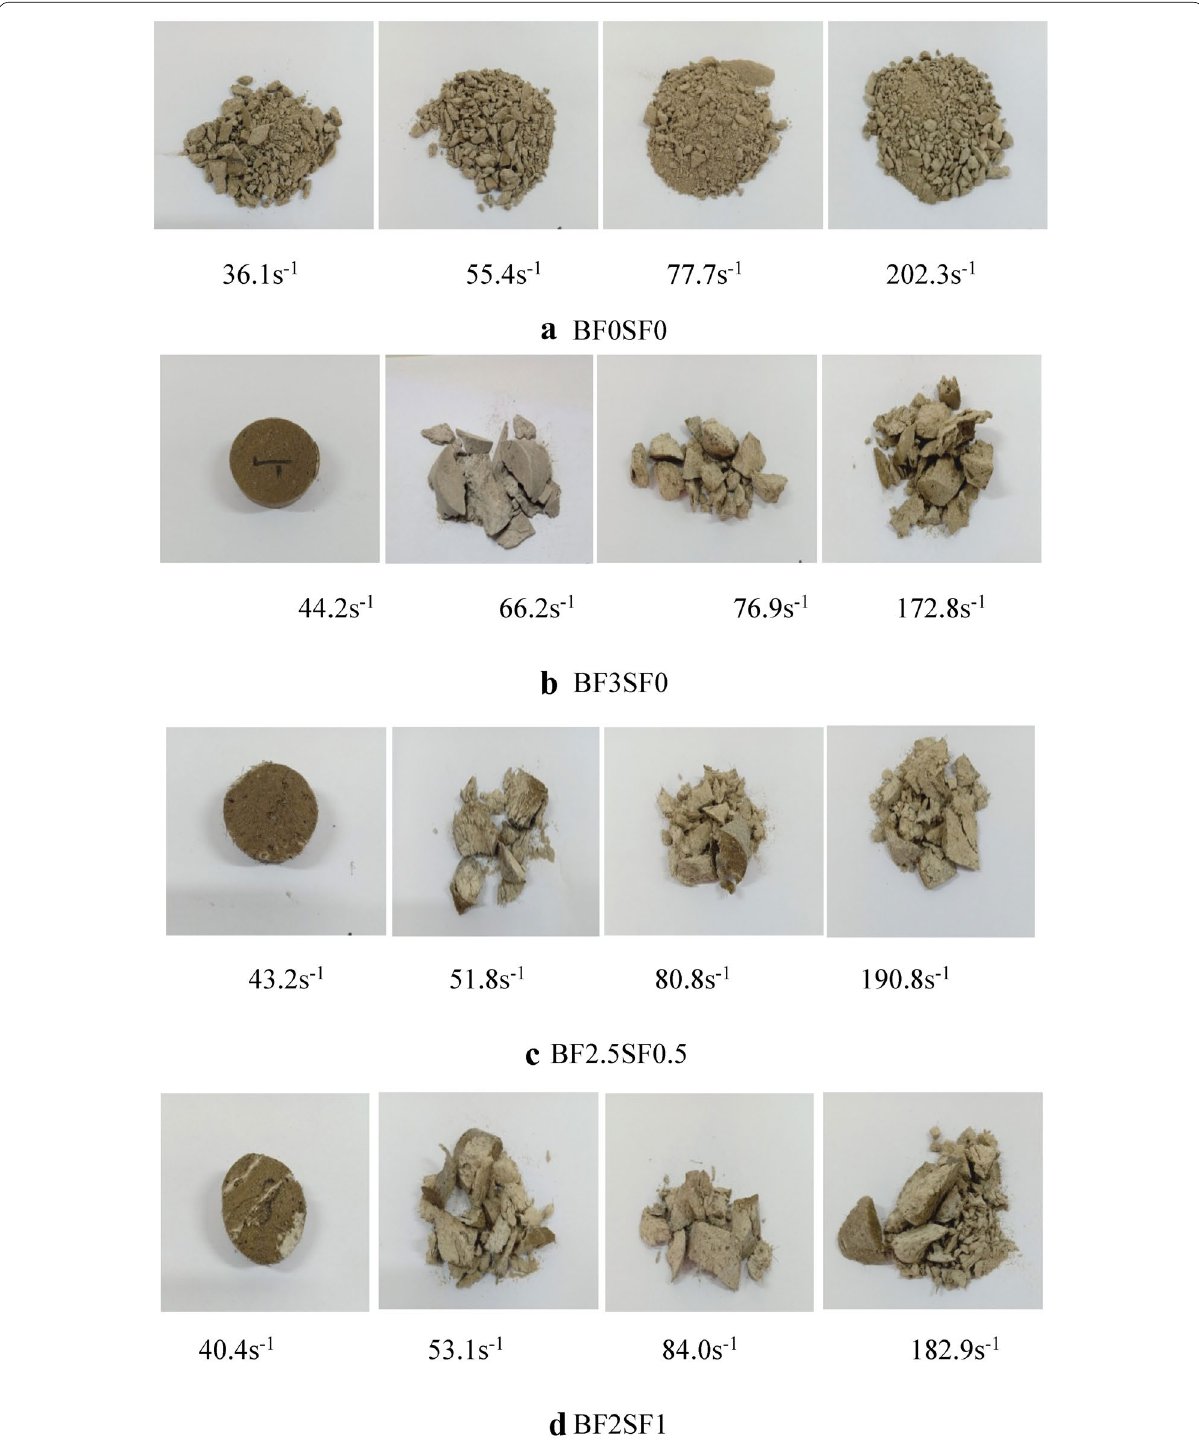
Fig. 6 Fracture patterns of SHCC samples under impact loads corresponding to different strain